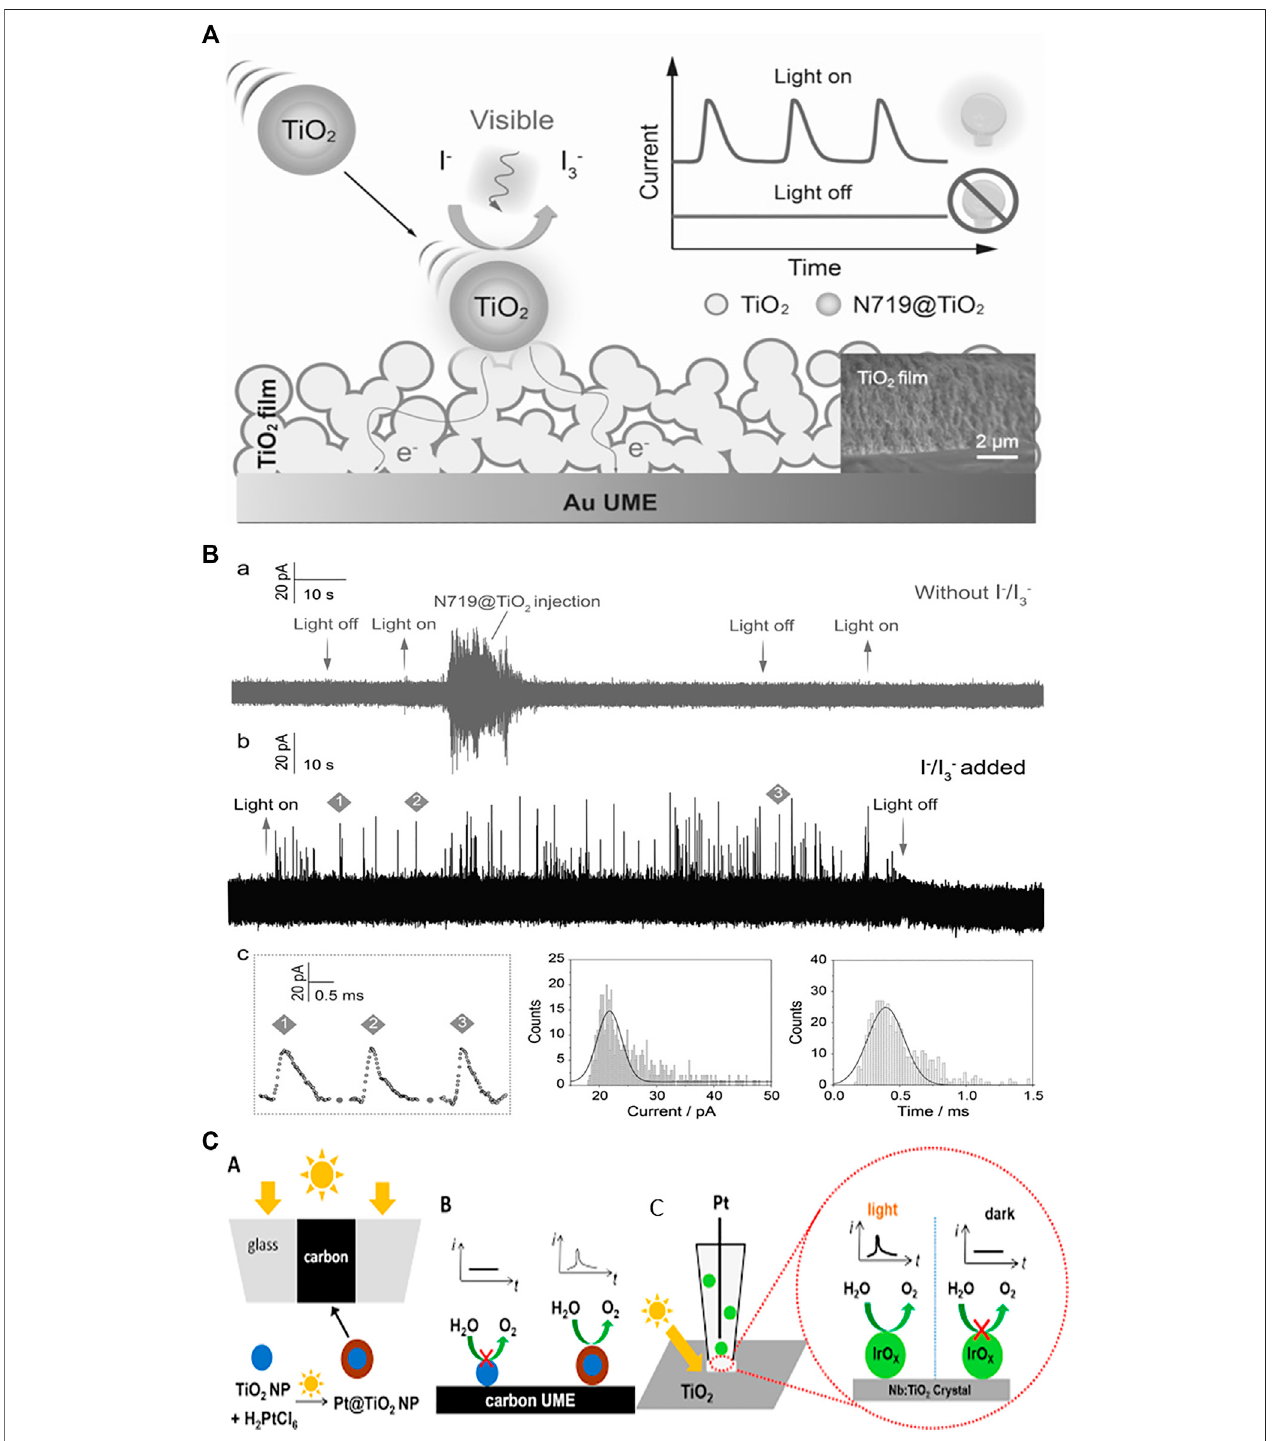
FIGURE2|(A) IllustrationofthephotoelectrochemicalbehaviorofasingleN719@TiO 2 nanoparticleduringacollisionwithaTiO 2 @AuUMEinthepresenceofI − /I 3 −